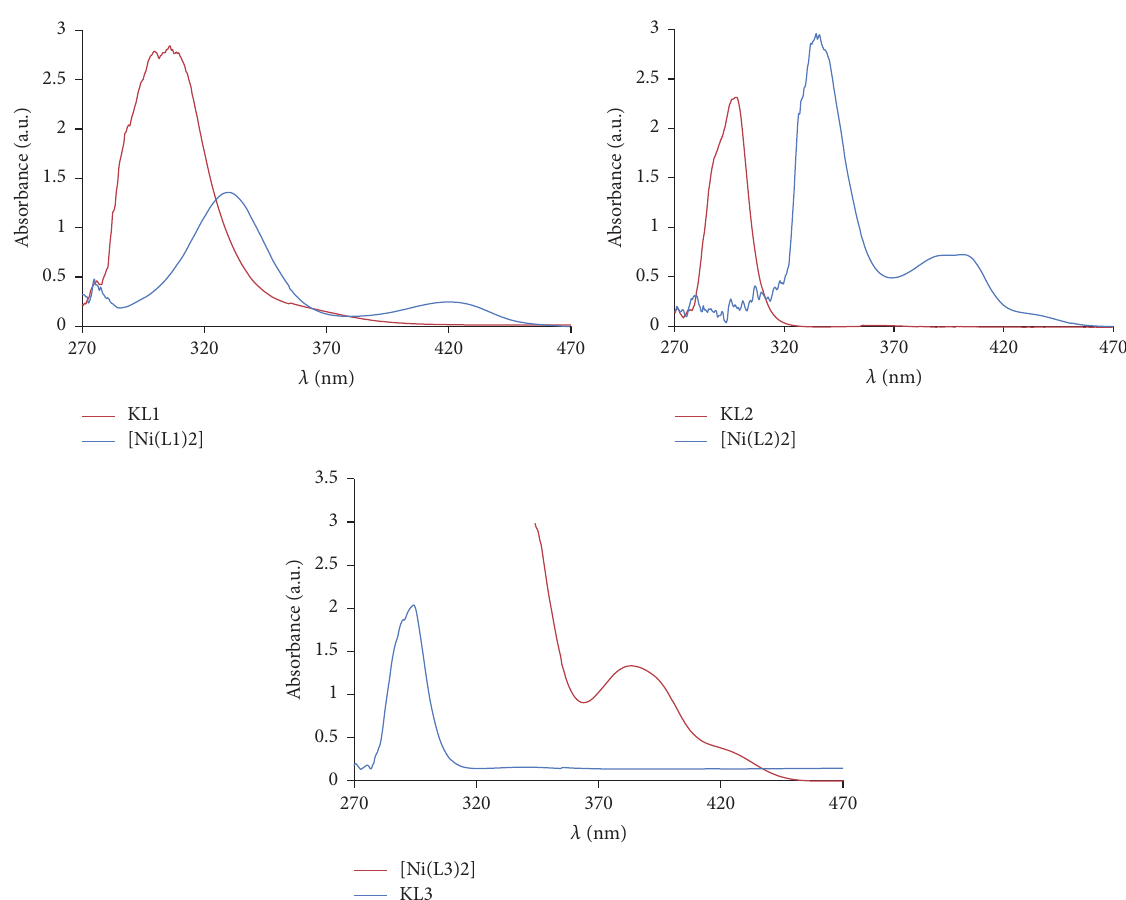
Figure 2: Electronic spectra of the ligands and the corresponding Ni(II) dithiocarbamate complexes.